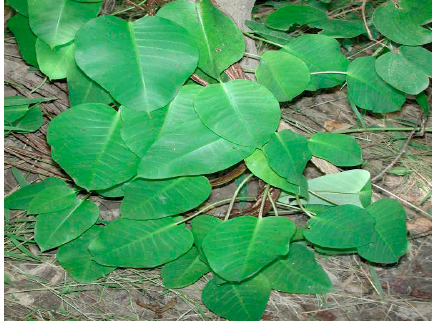
Figure 7. The leaf of Parquetina nigrescens.